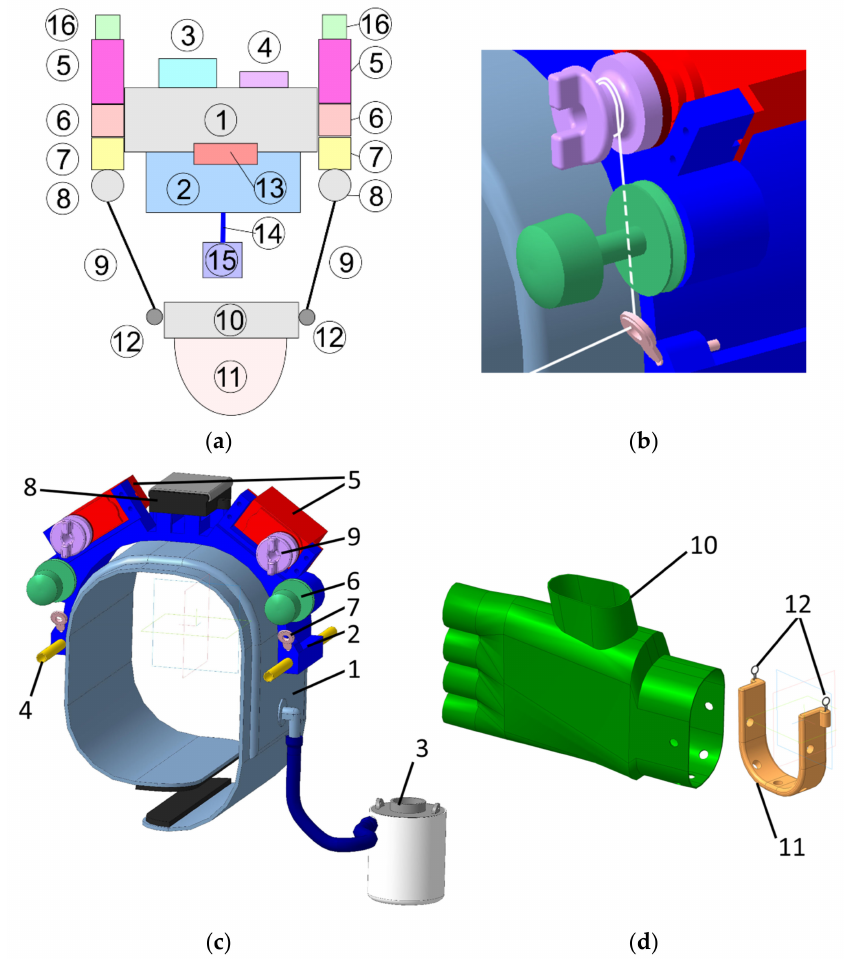
Figure 2. A design solution for the mechanical design L-CADEL v2: ( a ) A conceptual box diagram; ( b ) A scheme of a design solution for cable tensioning; ( c ) Upper module; ( d ) Lower